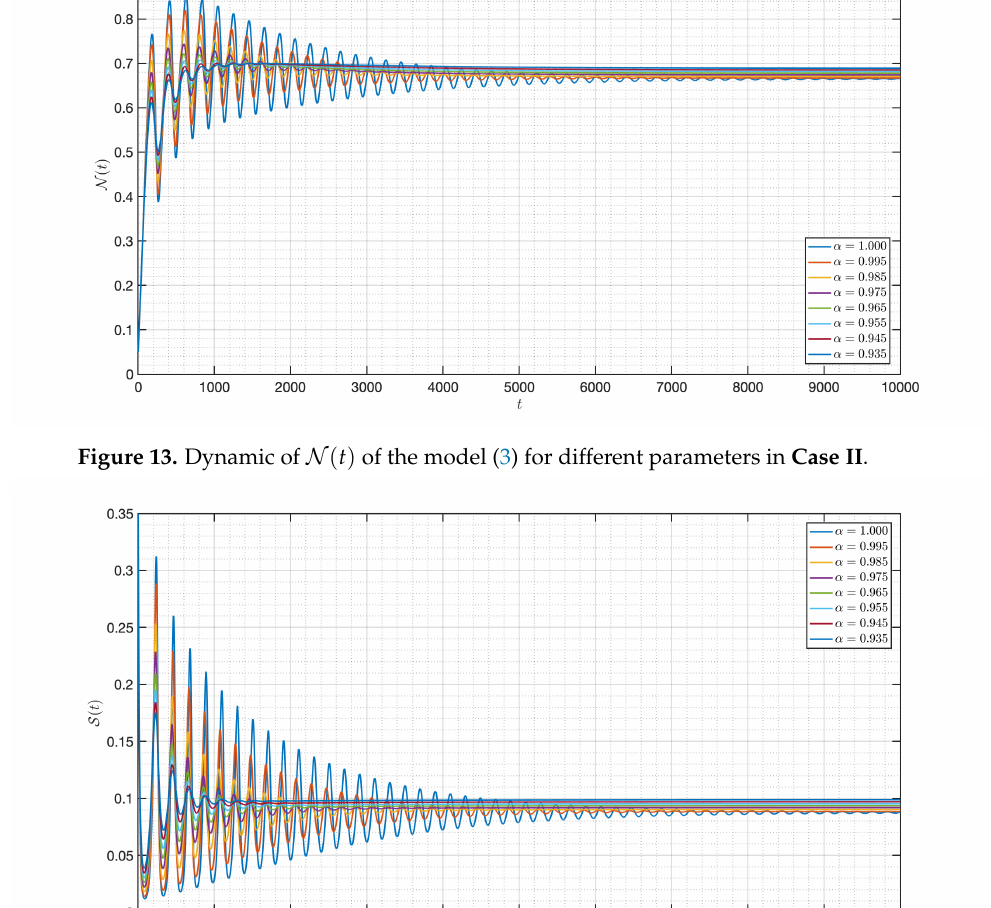
Figure 14. Dynamic of S ( t ) of the model (3) for different parameters in Case II